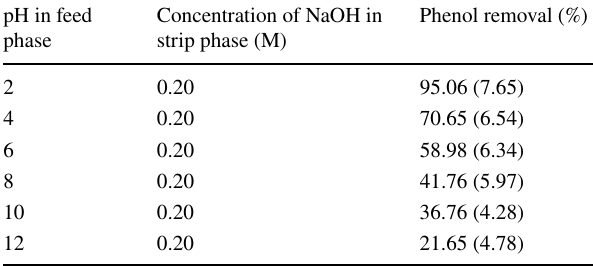
Table 2 Effect of pH solution of feed phase on the removal efficiency of phenol